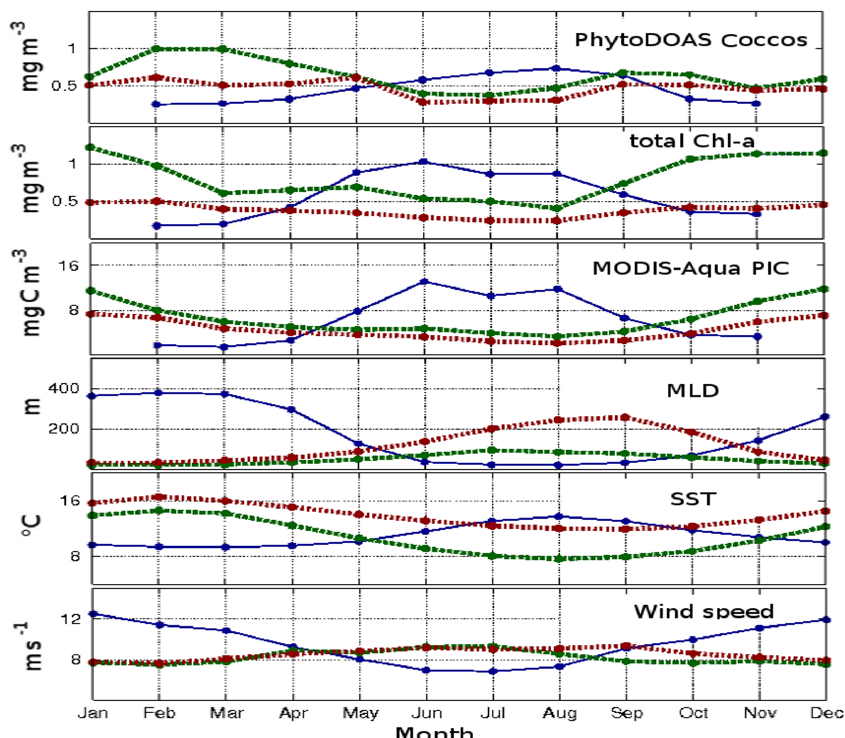
Fig. 11. Climatology curves of all monitored parameters in three selected regions. Each slot contains the climatologies of a certain parameter in three regions, which are denoted as follows: nAtl (blue line), sAtl (green dashed-line) and sPac (red dashed-line). The slots have been arranged in the same order as before, showing following parameters downward: PhytoDOAS coccolithophore chl-a ; GlobColour total chl-a ; MODIS-Aqua PIC conc.; MLD; SST; and surface wind-speed.